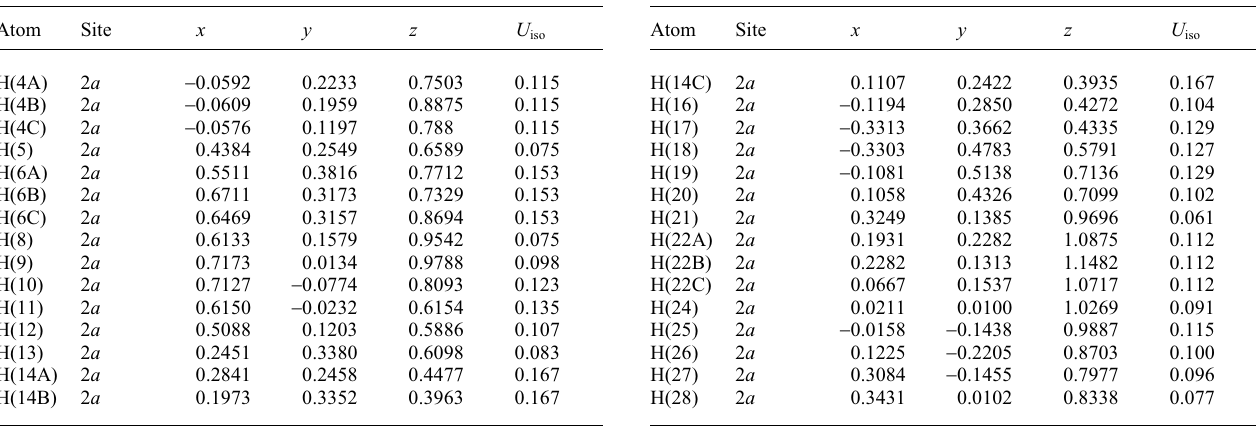
Table 3. Atomic coordinates and displacement parameters (in Å 2 )